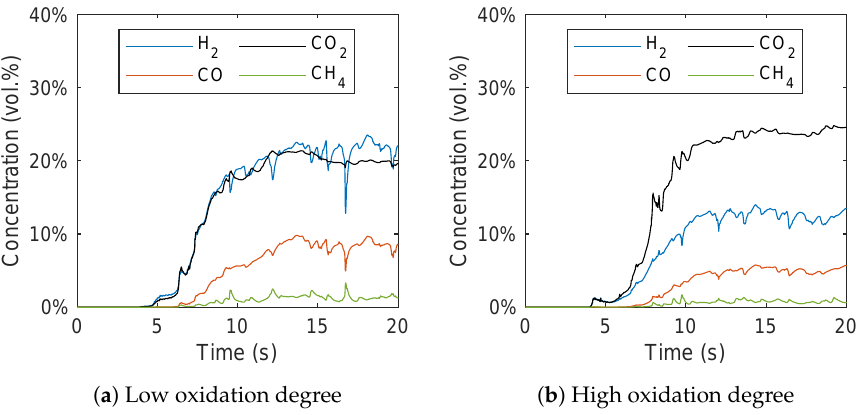
Figure 15. Gas species concentration plotted over time with a ( a ) low and ( b ) high oxidation degree of the oxygen